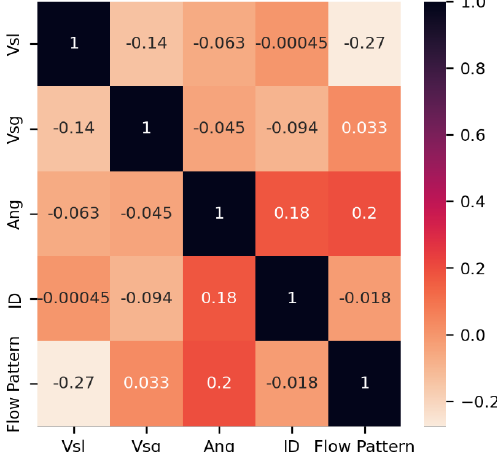
Figure 4. Heat map of correlation coefficient analysis between flow patterns and flow regime experimental features. V sl , V sg , Ang, and ID represent the superficial velocities of liquid, gas, angular inclinations, and pipe diameter, respectively.